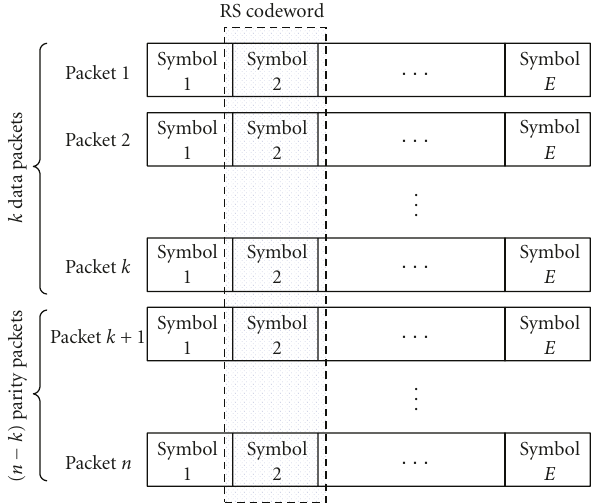
Figure 1: Packet-level coding structure using an RS( n , k )